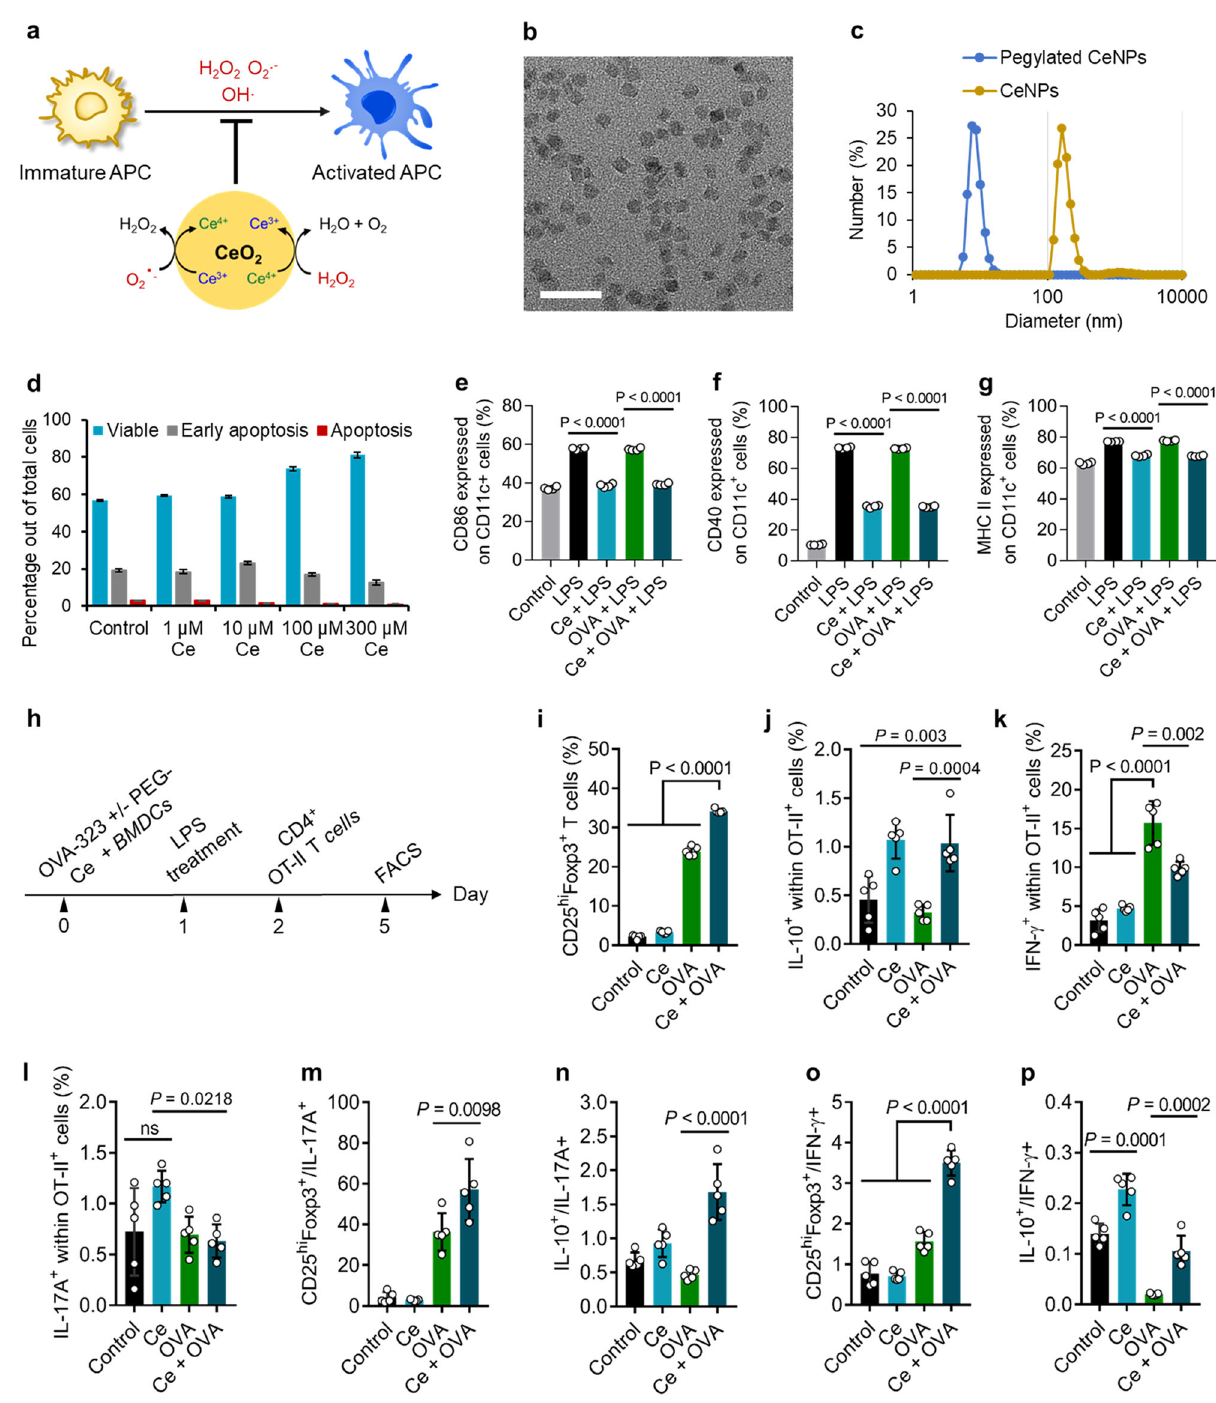
Fig. 5 | ROS-scavenging CeNPs induced tolerogenic APCs. a Scheme demon- strates the catalytic property of CeNPs to scavenge intracellular ROS for the sup- pression of APCs activation. b TEM images of CeNPs (scale bar: 20nm), the experiment was repeated independently at least three times. c Hydrodynamic size distribution of CeNPs and pegylated CeNPs in complete RPMI 1640 medium. d Apoptosis of BMDCs after 48h incubation with various cerium concentrations. BMDCswereincubatedwithpegylatedCeNPs(Ce,50 µ Mcerium),OVA 323 – 339 (OVA, 1 µ g/mL), pegylated CeNPs plus OVA 323 – 339 (Ce+OVA), or left untreated for 24h; following by LPS treatment (1 µ g/mL) for the next 24h; control is the bare BMDCs; n =3biologicallyindependentsamples. e – g ExpressionofCD86,CD40,andMHC-II on BMDCs, respectively; n =4 biologically independent samples. h BMDCs were